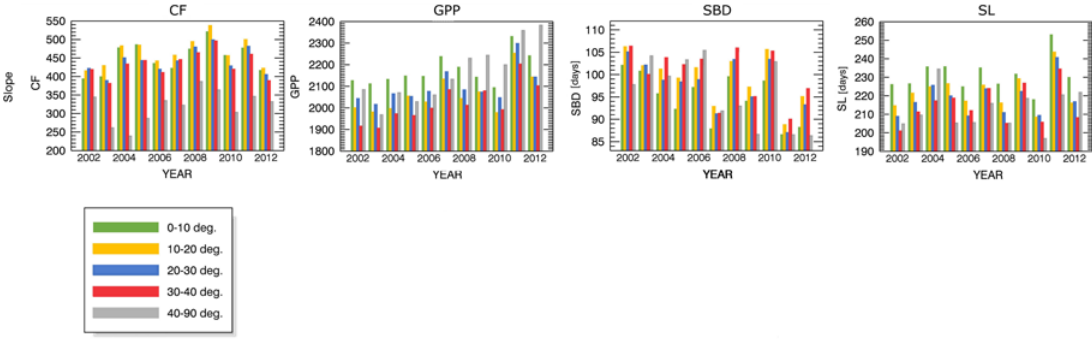
Figure A4. Marginal means plots of repeated measures ANOVA showing CF, GPP, SBD and SL variability in relation to slope. Analyses performed for the 3nNDVI drought impact class 1 spatial footprint. Abbreviations are explained in Table A1.